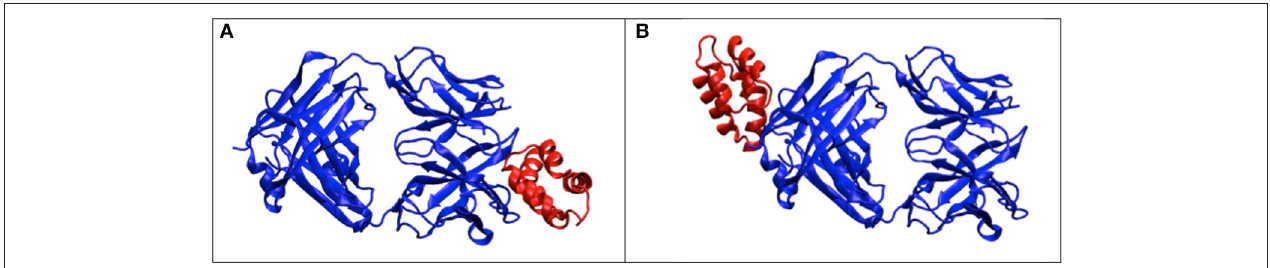
FIGURE 6 | The effects of symmetry. The dimer complex has a pseudo-symmetry (blue color), which may reduce the model ranking power of scattering data based scoring functions. (A) the correct structure for the complex; (B) the model that has similar electron density to (A) after rotation, but differs significantly from (A) in terms of